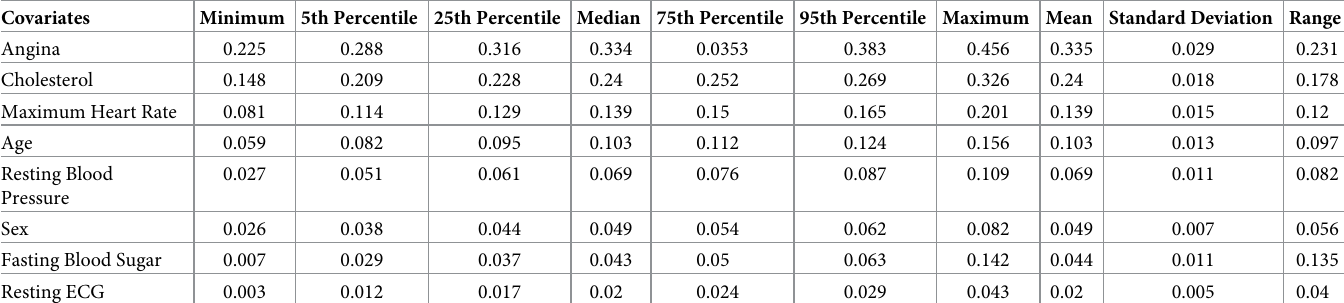
Table 3. Summary of model gain statistics for each covariate in the XGBoost model. Covariates